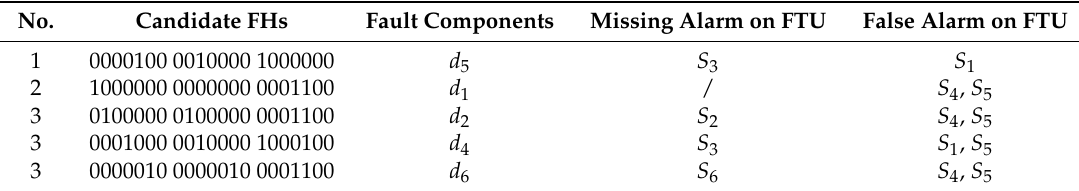
Table 6. Diagnosis using the upper-level analytic model in scenario